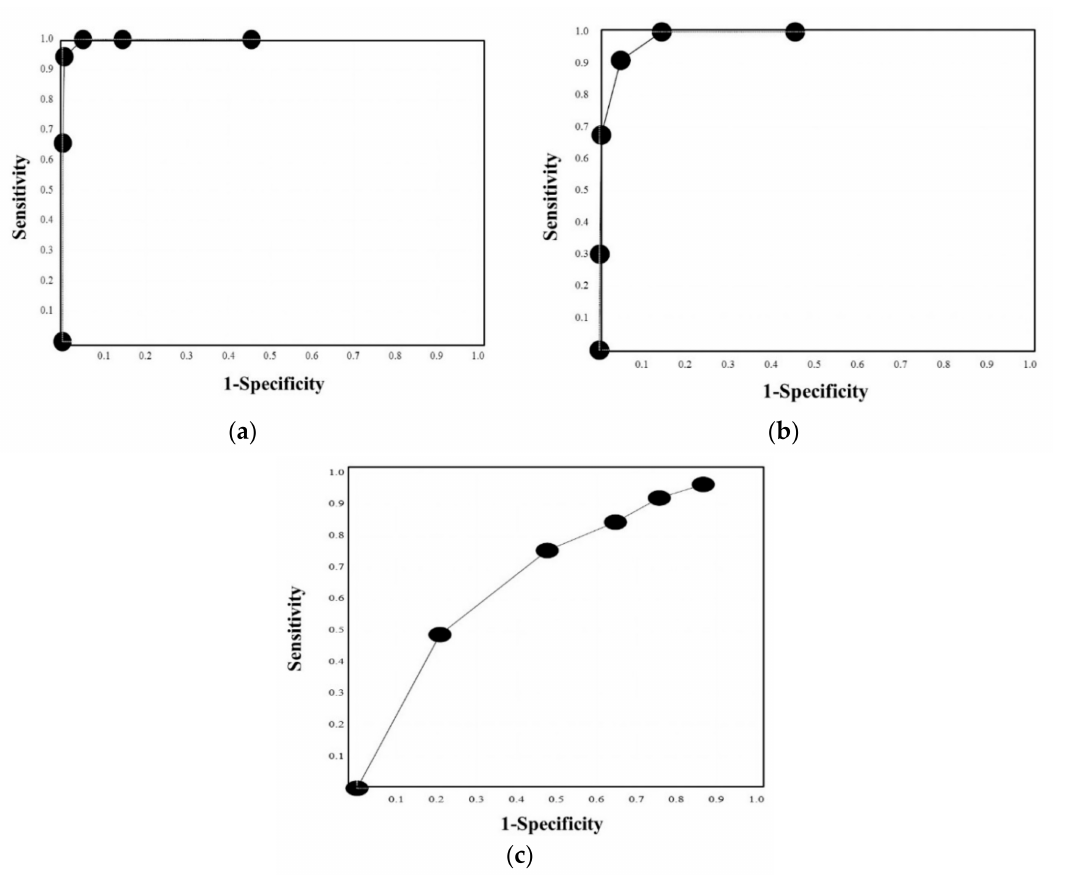
Figure 3. ROC curve of the quick DIC score for DIC vs. non-DIC ( a ), DIC and pre-DIC vs. non-DIC ( b ), or survivor vs. non-survivor ( c ). ROC, receiver operating characteristic; DIC, disseminated intravas- cular coagulation; area under the curve, ( a ) 0.997, ( b ) 0.984, and ( c )